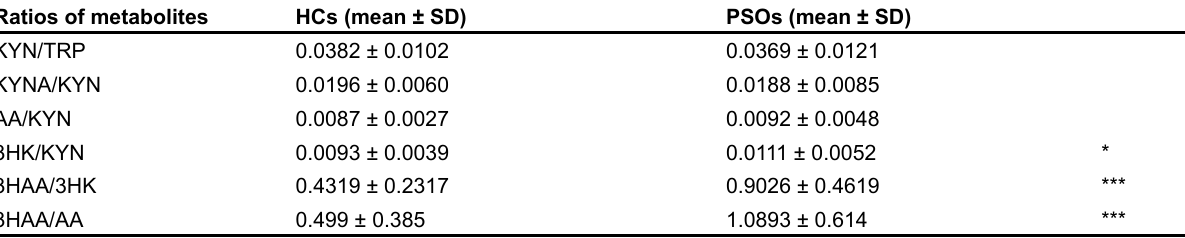
Table 2. Differences in the ratio of TRP-KYN pathway metabolites between HCs and PSOs Ratios of